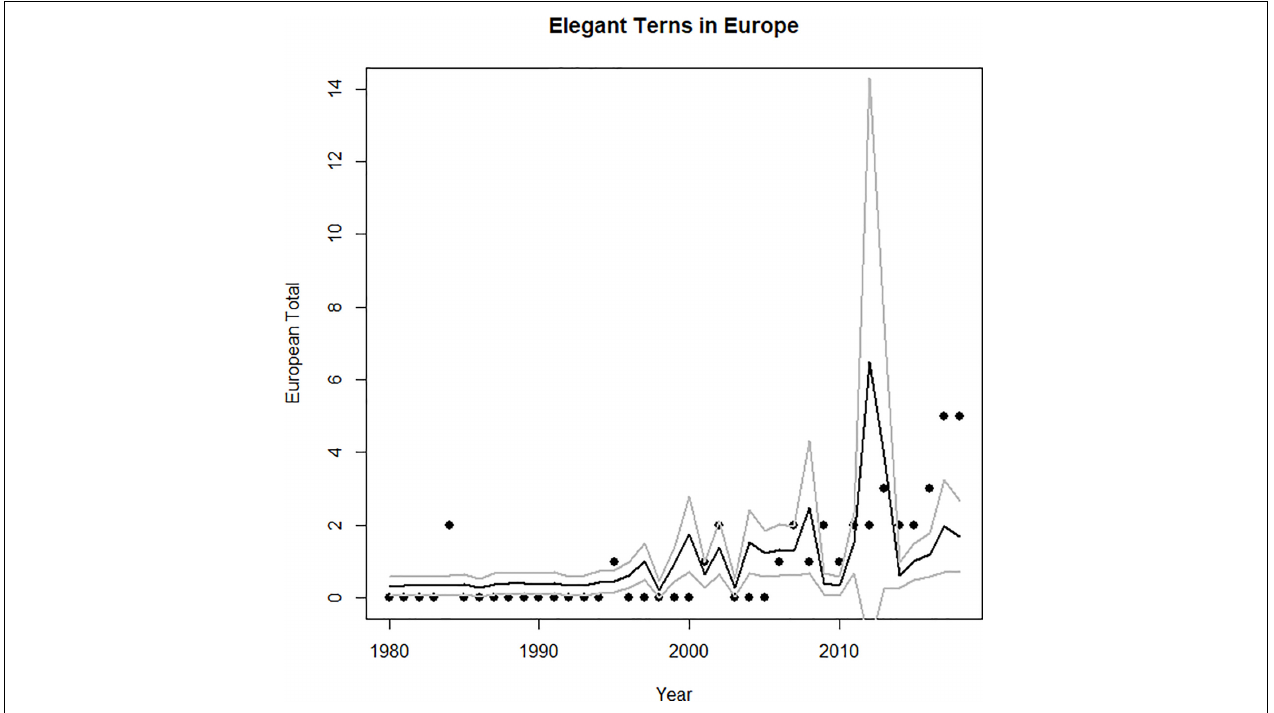
FIGURE 5 | Time series of abundance of vagrant elegant terns in Europe. Predicted values and confidence intervals shown for GAM ( Table 1 ) on each graph.